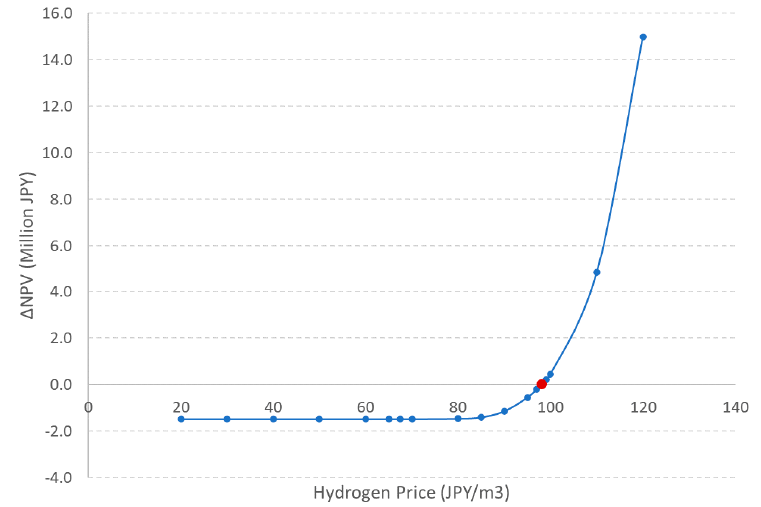
Figure 9. ∆ NPV for various hydrogen prices using the historical PDC as input. The red dot represents the breakeven LCOH.